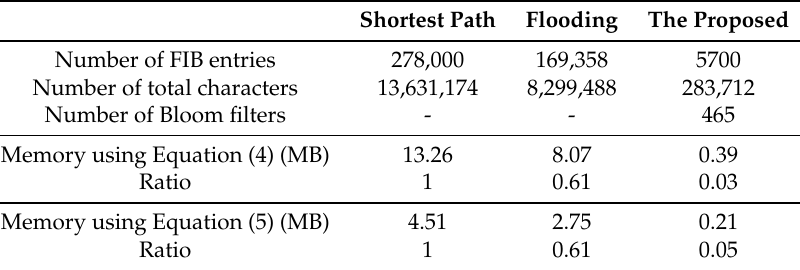
Table 5. Memory consumption of AS-1221.